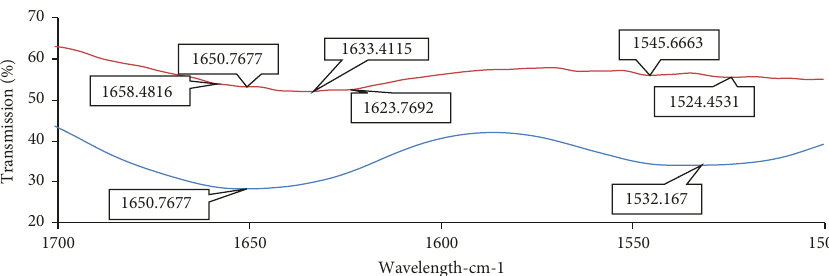
Figure 11: Expanded region (amide I and II) of the corresponding FTIR